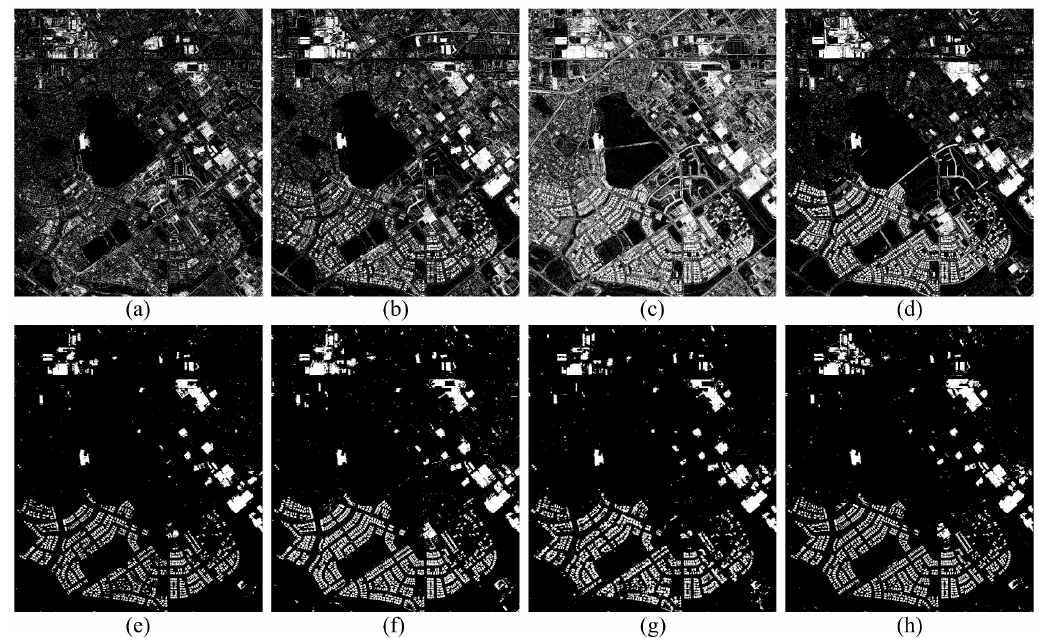
Figure 9. Binary change maps (Experiment 1) obtained by the ( a ) RCVA, ( b ) SVM, ( c ) RF, ( d ) DBN, ( e ) U-Net, ( f ) SegNet, ( g ) DeepLabv3+, and ( h ) Proposed method.